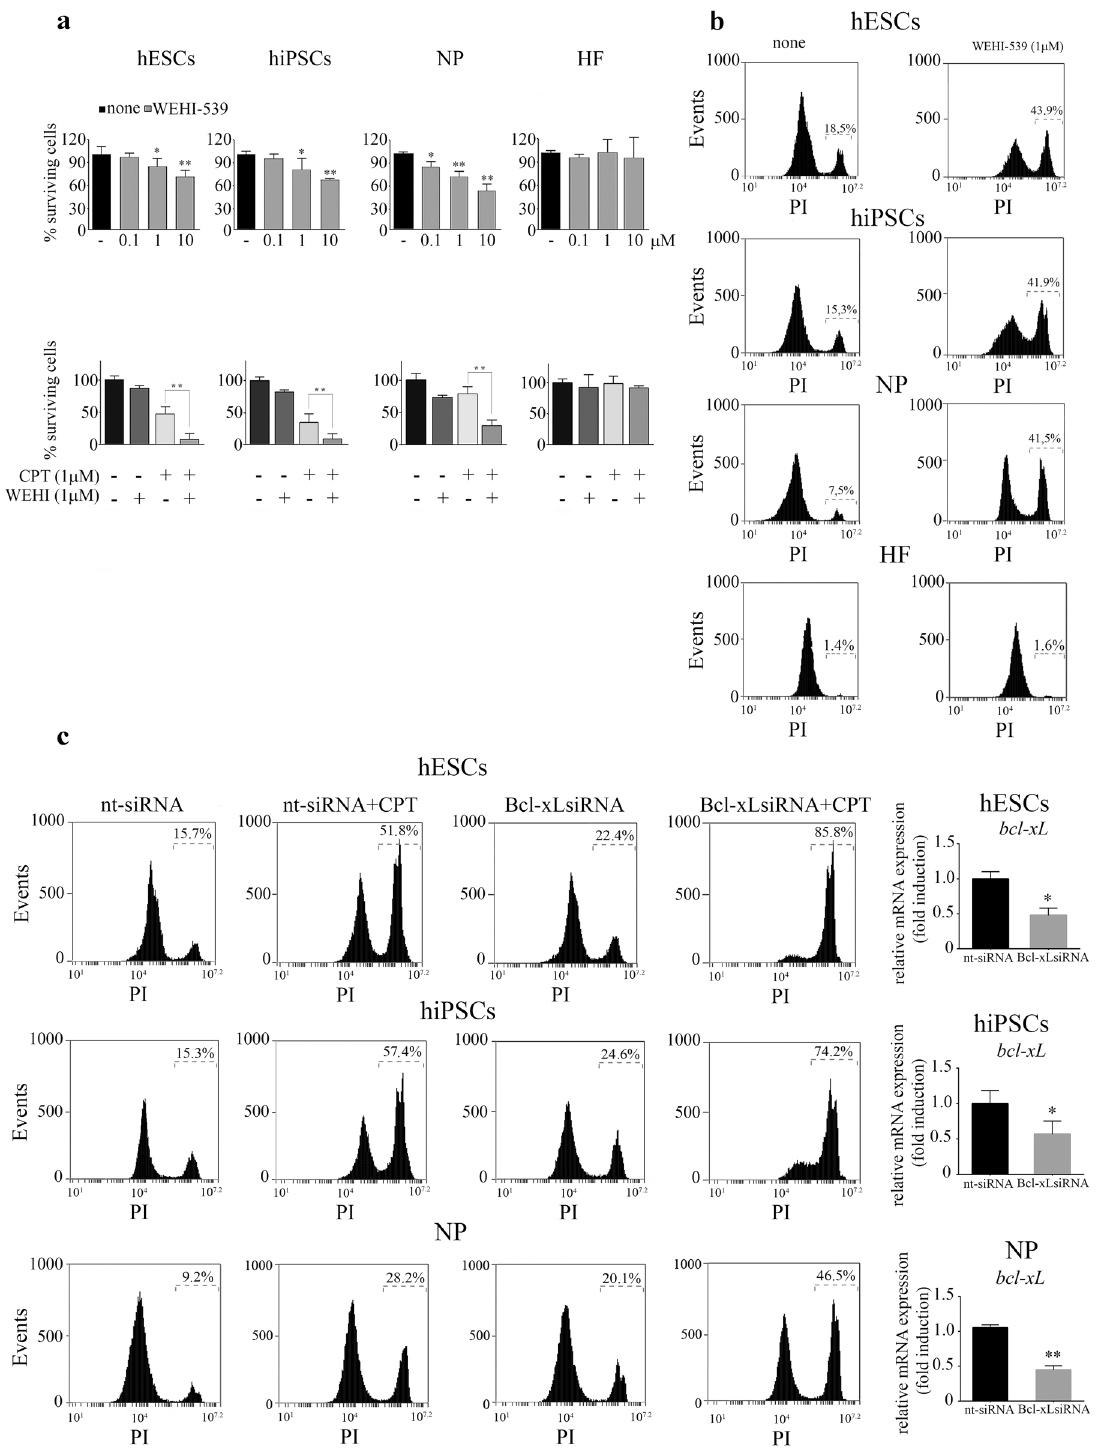
Fig 6. Pharmacological inhibition or siRNA-mediated down regulation of Bcl-xL sensitize hESCs, hiPSCs and NP to CPT induced DNA damage. (a) H9 hESCs, FN2.1 hiPSCs, hESCs-derived NP and HF were left untreated or treated with increasing concentrations of WEHI-539 (0.1 – 10 μ M) during 15h (top panel) or treated with CPT (1 μ M) for 3h or pre-treated with WEHI-539 (1 μ M) for 1h r and then exposed to CPT (bottom panel). Cell viability was measured by the XTT/PMS assay 15 h post WEHI-539 (1 μ M) addition or 6 h after CPT removal. Results are presented as the percentage of the viability of untreated cells. Each bar represents the mean ± SEM of three independent experiments performed in quintuplicate. A paired Student's t test was used